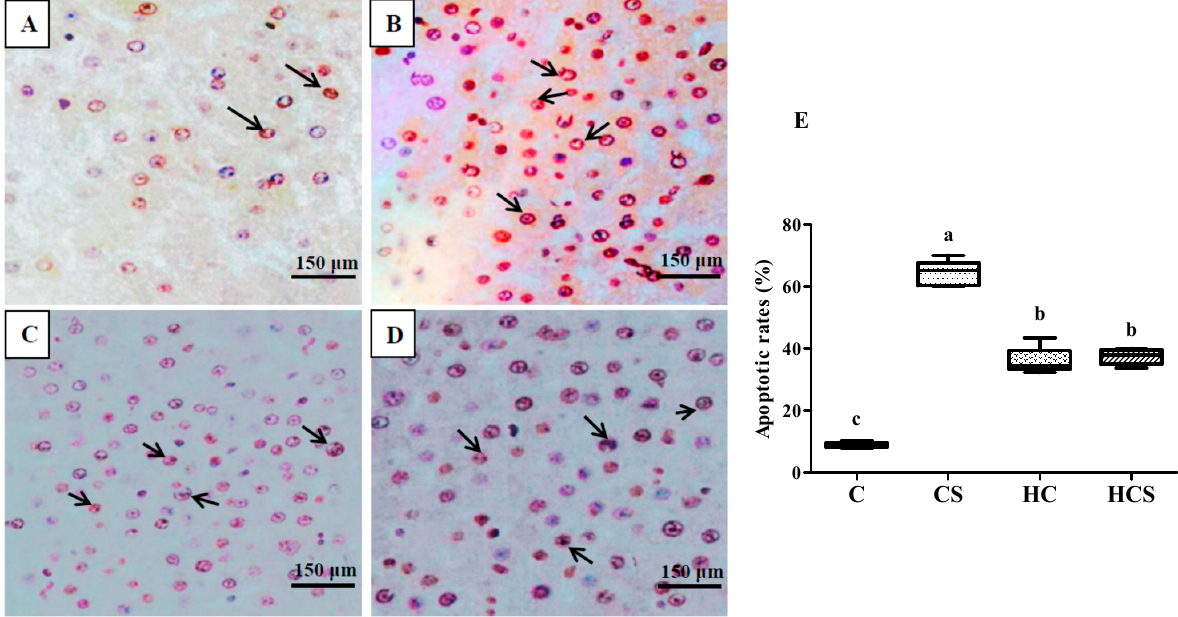
Figure 2. TUNEL detection of hepatic apoptosis of M. amblycephala subjected to different treatments: ( A ) the C group; ( B ) the CS group; ( C ) the HC group; ( D ) the HCS group. ( E ) is apoptotic rates. The brown fluorescence and white arrows indicate apoptotic cells. Each data point represents the mean ± SEM of four replicates. Bars assigned different superscripts (a, b and c) are significantly different ( p < 0.05). C, control diet; CS, control diet supplemented with 100 mg kg − 1 silver nanoparticles (Ag-NPs); HC, high-carbohydrate (HC) diet; HCS, HC diet supplemented with 100 mg kg − 1 Ag-NPs (the same